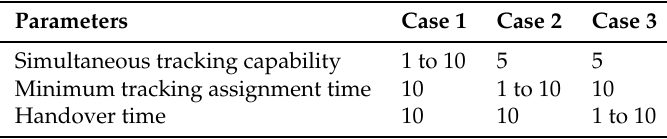
Table 5. Parameter setting for sensitivity analysis.